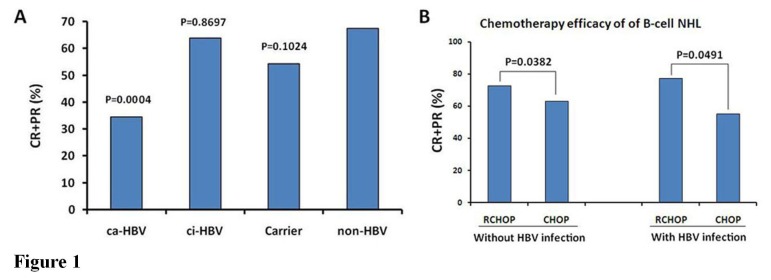
Relationship between HBV infection status and clinical outcome of chemotherapy in NHL patients.(A) The treatment efficacy was evaluated in 780 patients with NHL who received different types of chemotherapy regimens, and the relationship between the HBV infection status (ca-HBV, chronic active HBV infection; ci-HBV, chronic inactive HBV infection; Carrier, HBV carrier with HBsAg-positive; non-HBV, no HBV infection with HBsAg-negative) and the clinicopathological characteristics of lymphoma were analyzed by a chi-square test. (B) The analysis of the B-cell NHL patients who received RCHOP and CHOP chemotherapy regimens revealed that the effect of rituximab in chemotherapy was found to be more efficient in the groups without and with HBV infection.